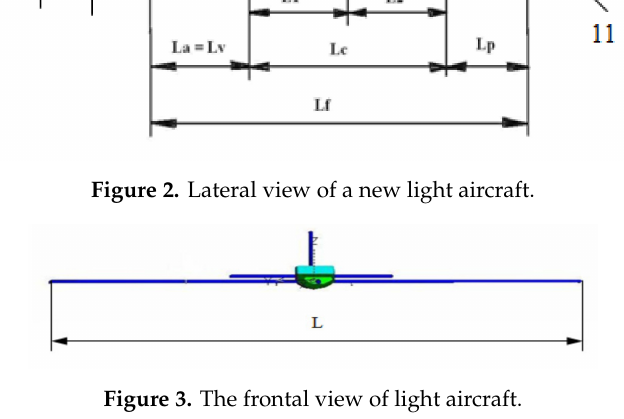
Figure 3. The frontal view of light aircraft.